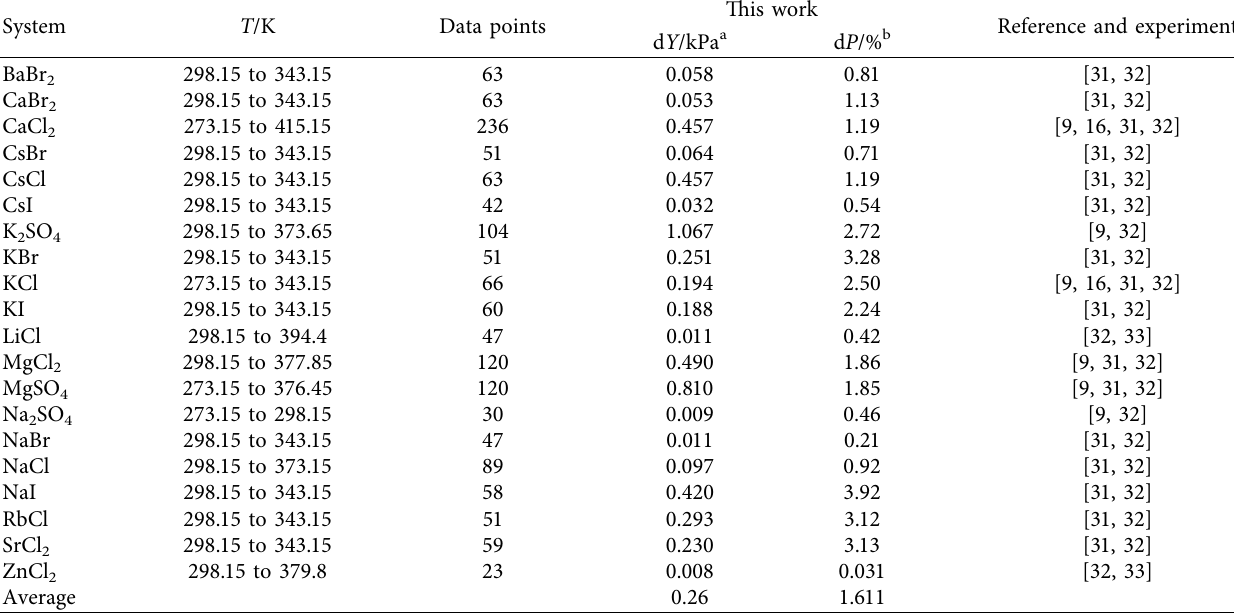
Table 5: Correlation of VLE data.